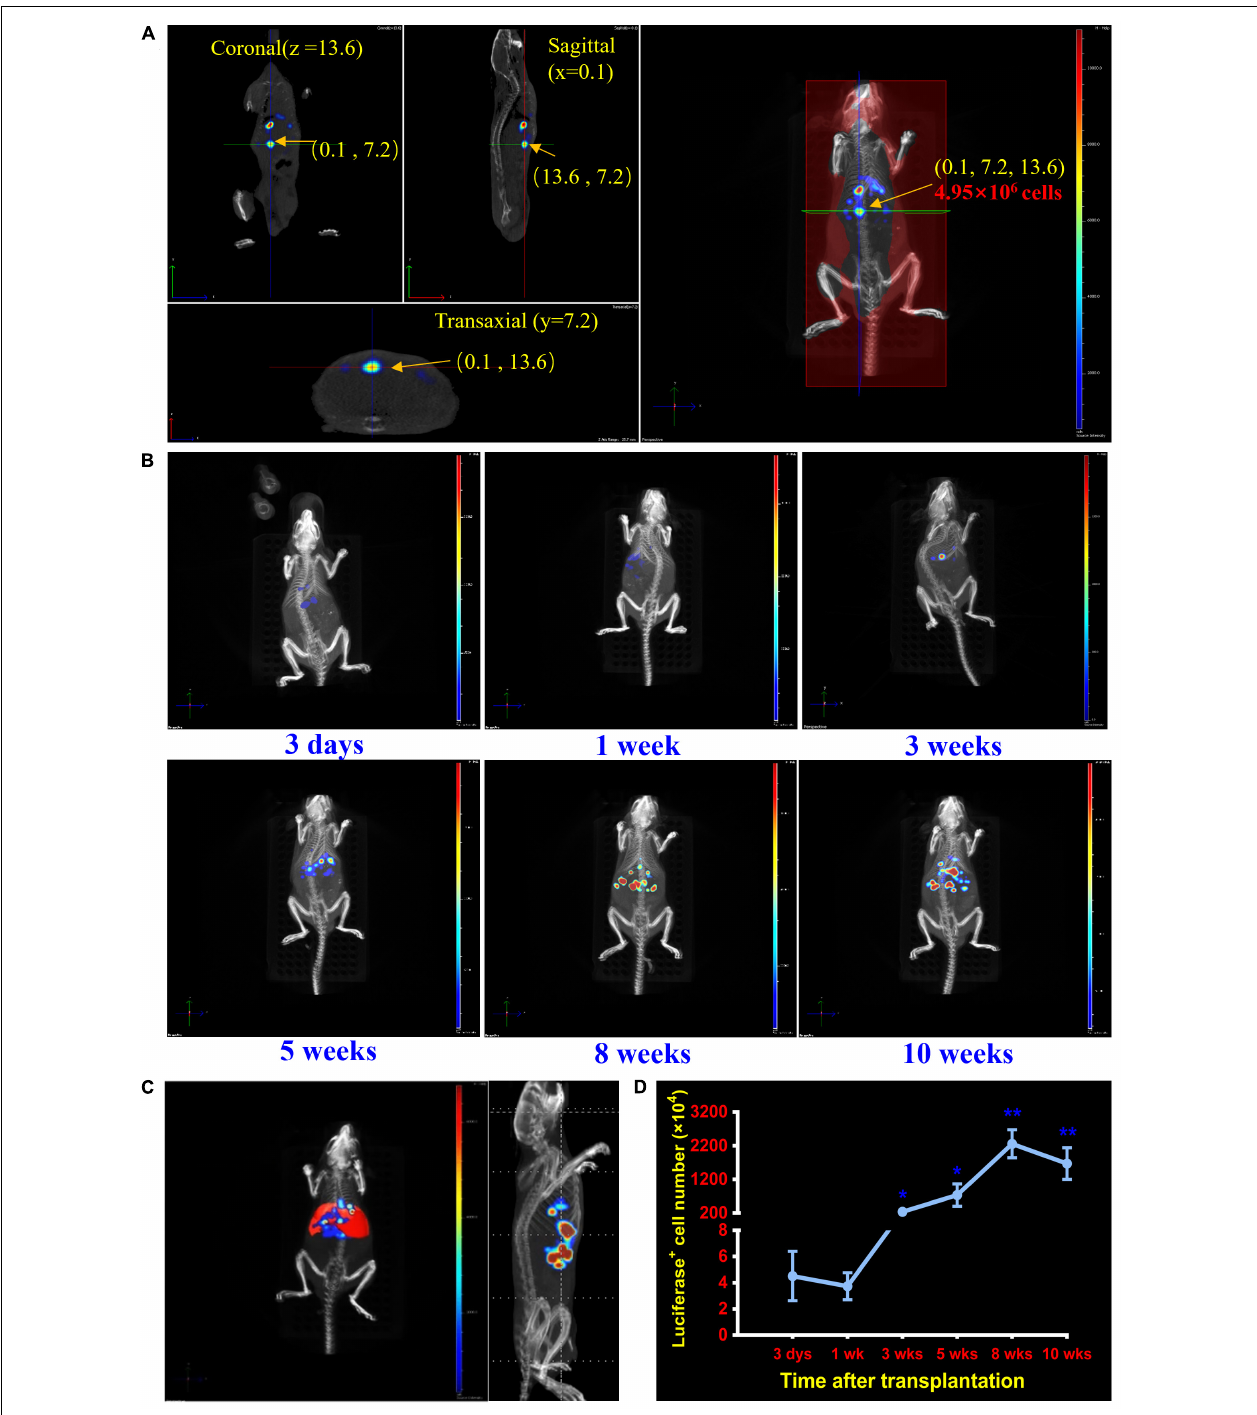
FIGURE 1 | Localization and quantification analysis of transplanted cells in the liver of Fah − / − mice. (A) Establishment of the dynamic cell-tracking strategy for posttransplantation localizing and quantifying of grafted cells in vivo . A combination of 3D BLI and CT is established to locate and quantify the transplanted hepatocytes in livers of Fah − / − mouse recipients at any time point of detection. Representative image of accurate localization (0.1, 7.2, 13.6) cm and cell quantification (4.95 × 10 6 ) of one nodule repopulated by transplanted hepatocytes (pointed by the arrow). (B) Dynamically localizing transplanted hepatocytes at different time points posttransplantation. Representative merged images of transplanted hepatocytes of Fah − / − mice at 3 days, 1, 3, 5, 8, and 10 weeks after hepatocyte transplantation. (C) Spectrum CT image of mouse liver was reconstructed by Living Image 4.5 software in Fah − / − mouse. (D) Quantification of transplanted hepatocytes in livers of Fah − / − mice at 3 days, 1, 3, 5, 8, and 10 weeks. Quantitative analyses of transplanted hepatocytes in liver of Fah − / − mice. Data are shown as mean ± SEM. * p < 0.05, ** p < 0.01. N = 3. Student’s t -test.